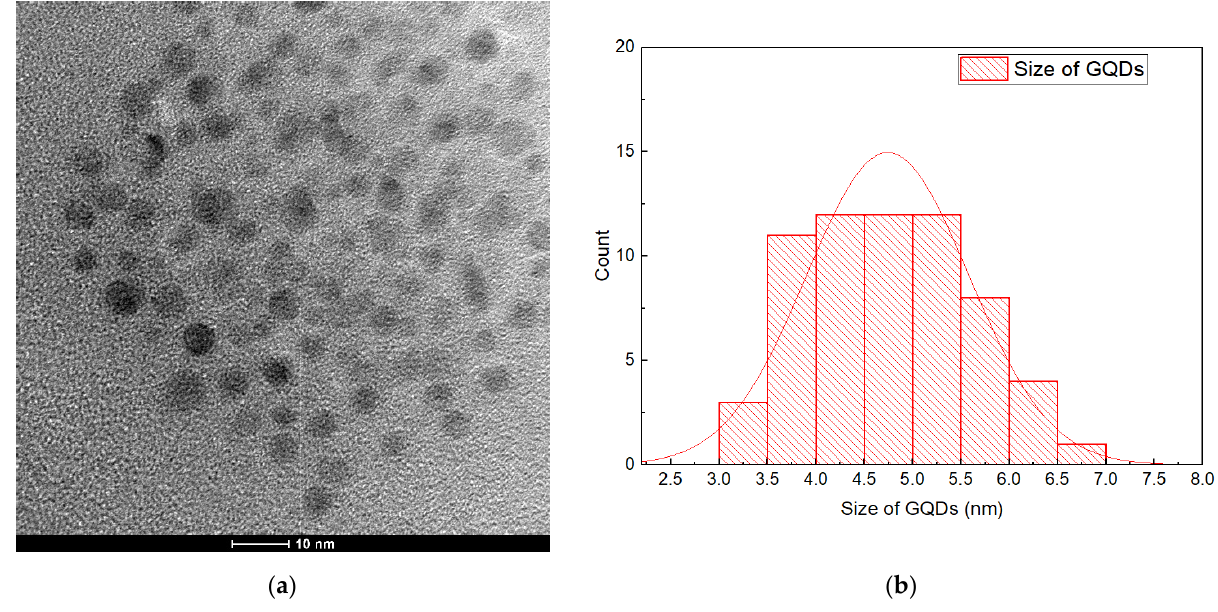
Figure 5. ( a ) TEM images of GQDs; ( b ) particle size distribution of GQDs.